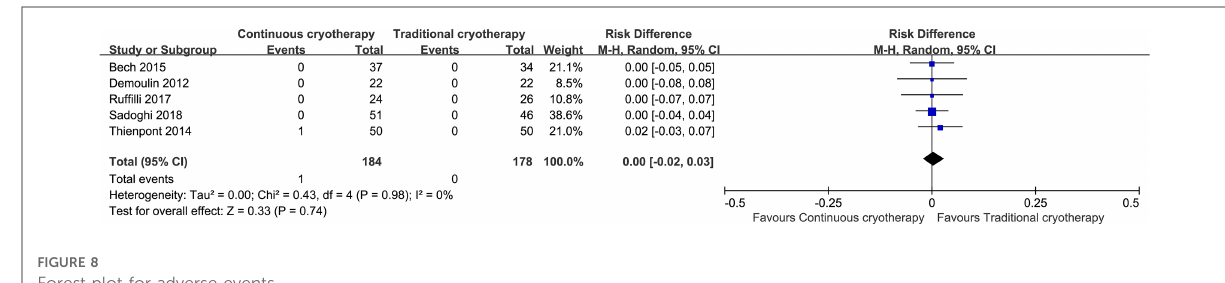
FIGURE 8 Forest plot for adverse